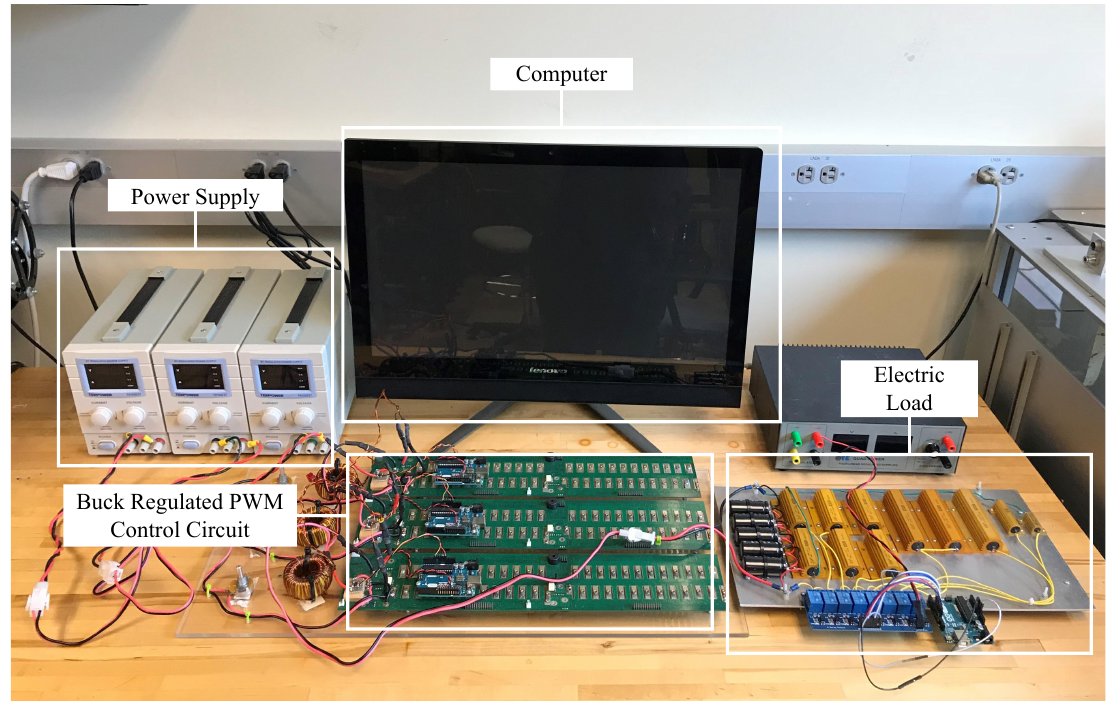
Figure 7. Photograph of the experimental battery tester.